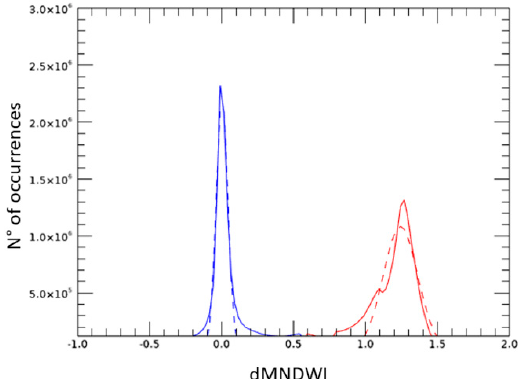
Figure 5. Histograms (continuous lines) of the pixels values of dMNDWI for the clustering-derived changed area (red) and the buffer zone (blue). The EMSR342 test case (Queensland flood) and the T54KVE tile are considered. The dashed lines represent the Gaussian fitting functions.